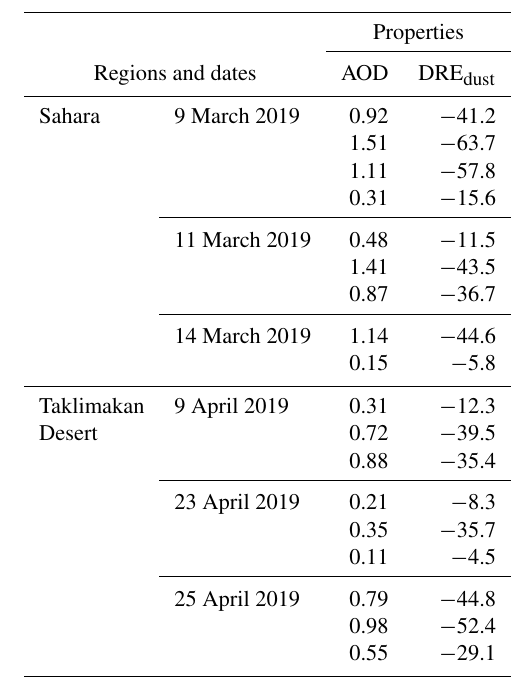
Table 1. DRE dust at the TOA and AOD over the Sahara in March 2019 and that over the Taklimakan Desert in April 2019 during the dust storms.